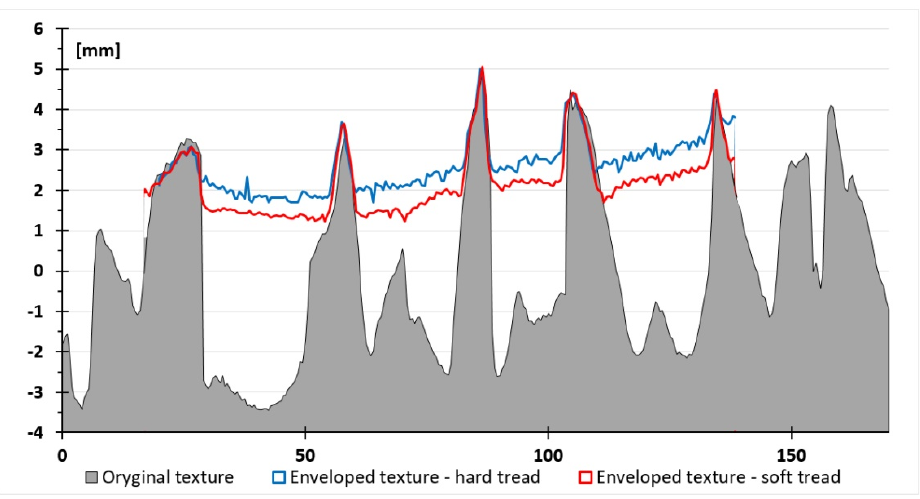
Figure 13. Profile of APS pavement and profiles of tread deflections of HARD and SOFT tires.